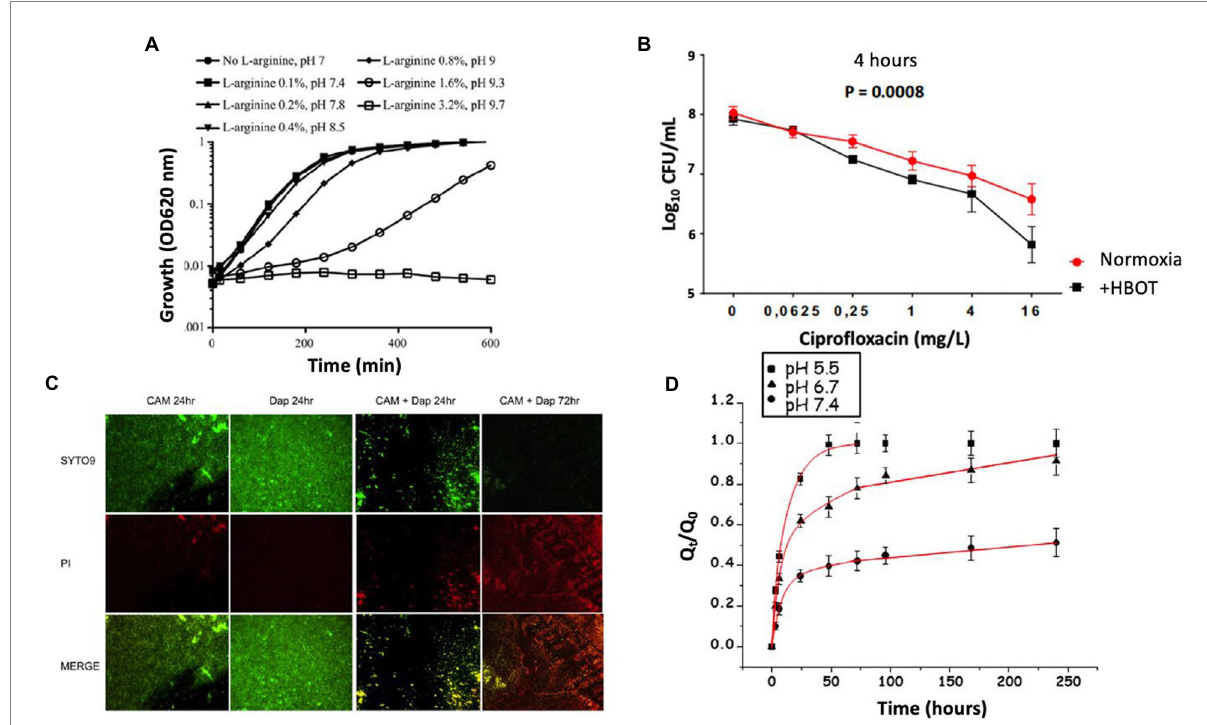
FIGURE 10 Results of different therapeutic strategies used to target biofilm pH to improve antibiotic activity in biofilms. (A) Growth curves in TSB glucose solutions without antibiotics, with increasing concentration of L-arginine for S. aureus Xen36 (Lebeaux et al., 2014). (B) Bacterial susceptibility to ciprofloxacin (calculated as log 10 colony forming units/mL) after 4 h HBOT treatment of agarose-embedded P. aeruginosa PAO1 biofilms. (Kolpen et al., 2016). (C) Fluorescence microscopy images of MRSA on metal surface treated with clarithromycin, daptomycin, and combination of clarithromycin and daptomycin (green indicates live cells and red indicates dead cells; Fujimura et al., 2015). (D) The cumulative amount of levofloxacin released (Q t ) with respect to the initial amount of levofloxacin in the scaffold (Q 0 ) versus time at pH 5.5, pH 6.7, and pH 7.4 (Cicuéndez et al.,